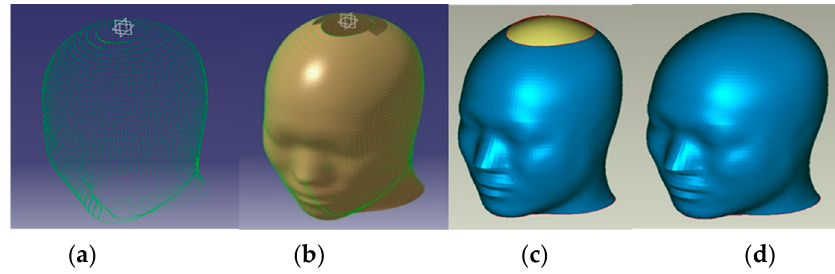
Figure 2. Head model reconstruction procedure: ( a ) point cloud; ( b ) layered scan; ( c ) hierarchical modeling; ( d ) head model.